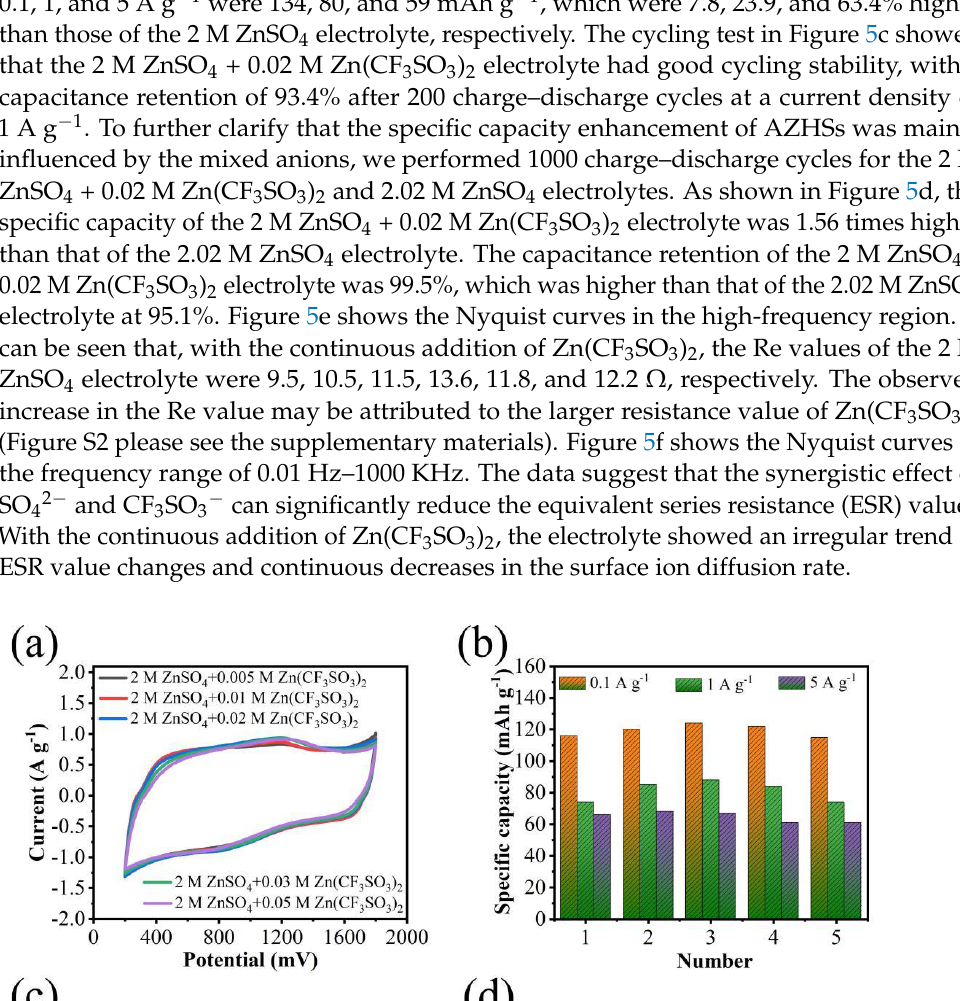
Figure 5. ( a ) Comparison of five CV curves (5 mV s −1 ); ( b ) Numbers 1, 2, 3, 4, and 5 are 2 M ZnSO 4 + 0.005 M Zn(CF 3 SO 3 ) 2 , 2 M ZnSO 4 + 0.01 M Zn(CF 3 SO 3 ) 2 , 2 M ZnSO 4 + 0.02 M Zn(CF 3 SO 3 ) 2 , 2 M ZnSO 4 + 0.03 M Zn(CF 3 SO 3 ) 2 , and 2 M ZnSO 4 + 0.05 M Zn(CF 3 SO 3 ) 2 electrolytes, respectively; ( c ) Cycling performance (1 A g −1 ) of hybrid anionic electrolyte; ( d ) Cycling performance (5 A g −1 ) of electrolyte